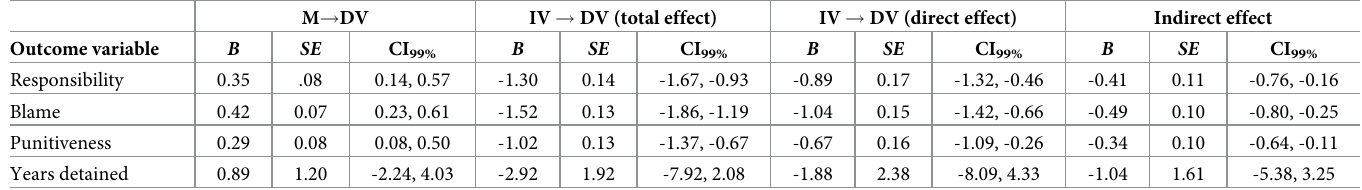
Table 2. Mediation model statistics: Effects of defense of mental impairment on crime judgments via agency (Study 1).